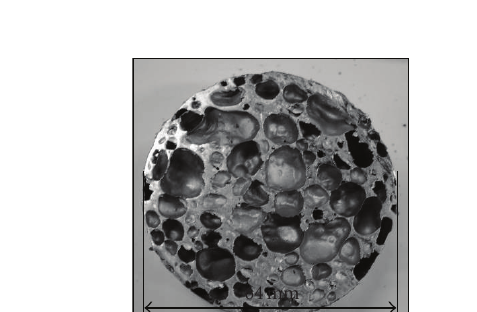
Figure 10: Relative density gradient data.